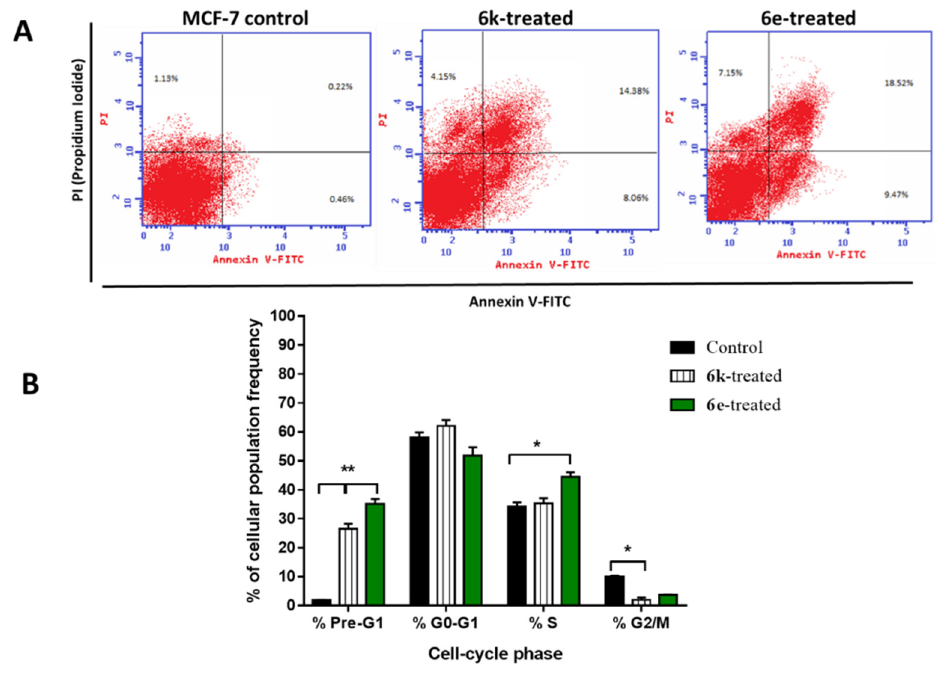
Figure 5. ( A ) Cryptographs of annexin-V/Propidium Iodide staining of untreated and 6k and 6e - treated MCf-7 cells with the IC 50 values, 48 h, Q1-UL (necrosis, AV − /PI+), Q1-UR (late apoptotic cells, AV+/PI+), Q1-LL (normal cells, AV − /PI − ), Q1-LR (early apoptotic cells, AV+/PI − ), ( B ) Bar representation of the percentage of cell population at each cell cycle G0-G1, S, G2/M, and Pre-G1 using DNA content–flow cytometry-aided cell cycle analysis. The data demonstrated is the mean of 3-independent experimental runs (mean ± SD). ** p < 0.001 and * p < 0.05 compared to control using an unpaired t test by GraphPad prism.